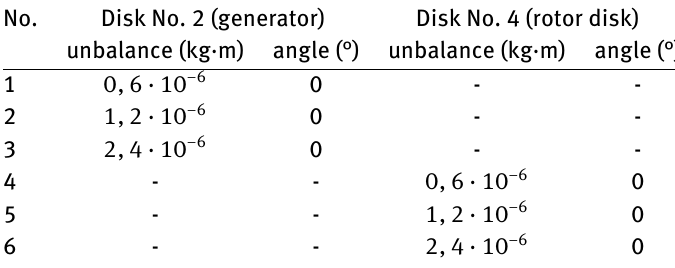
Table 1: The cases of one disk unbalance in the investigated micro-turbine.